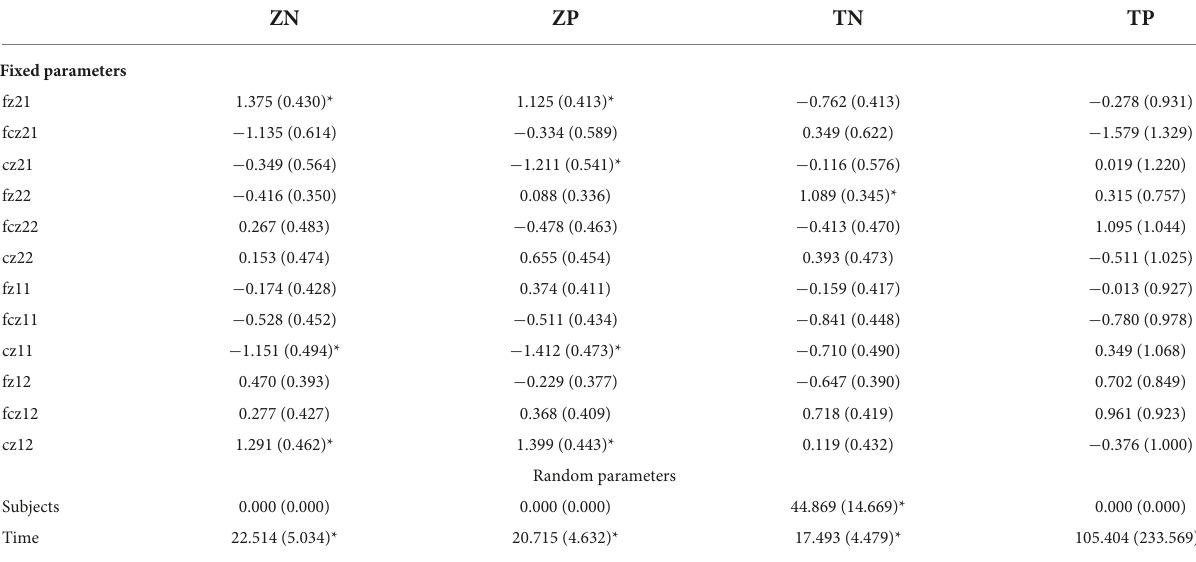
TABLE 7 The correlations analysis between ERP P2 component and accuracy rates on pain empathy paradigm.